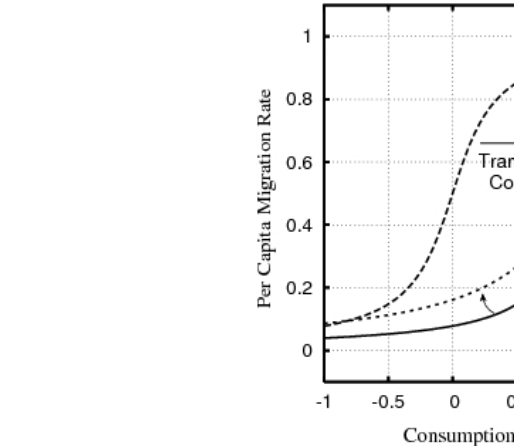
Fig. 3 . Examples of the migration function (y-axis scale on left), f(x,a and g(x,a ,b ) = arctan(a (x - b ))/ p (y-axis scale on right) for different values of a g g g g parameters a and a control the steepness of the function, i.e., how well agents can measure and assess m g differences in consumption possibilities or how rapidly population growth increases with higher food intake, respectively. The parameters b and b shift the functions horizontally. Shifting the function to m g the right could represent increasing transaction costs to migrate or a higher nutritional threshold before population growth becomes